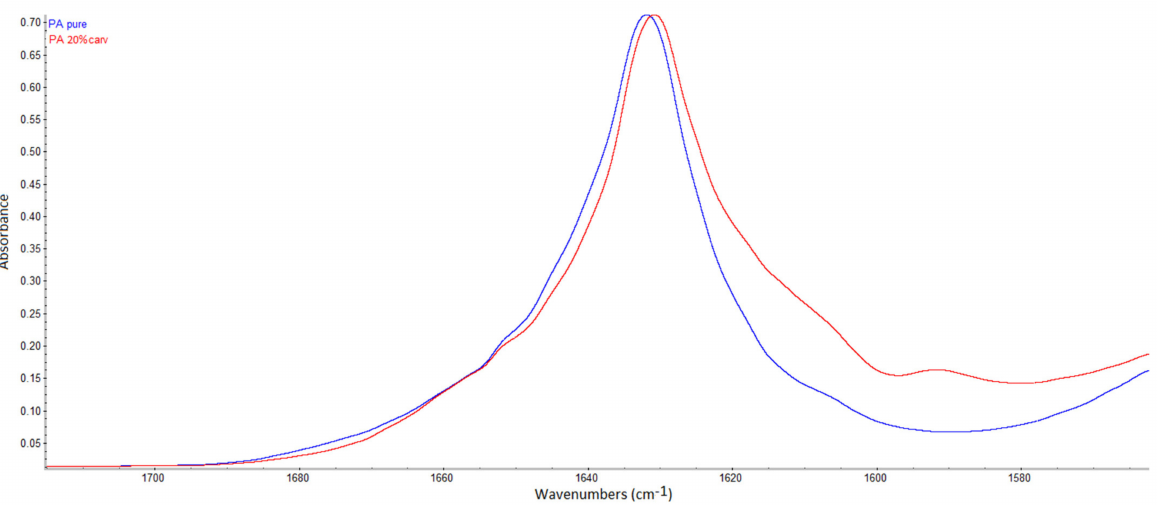
Figure 5. C=O stretching vibration band in polyamide (peak at 1631 cm − 1 ) and a slightly broader band in the impregnated sample (peak at 1630 cm − 1